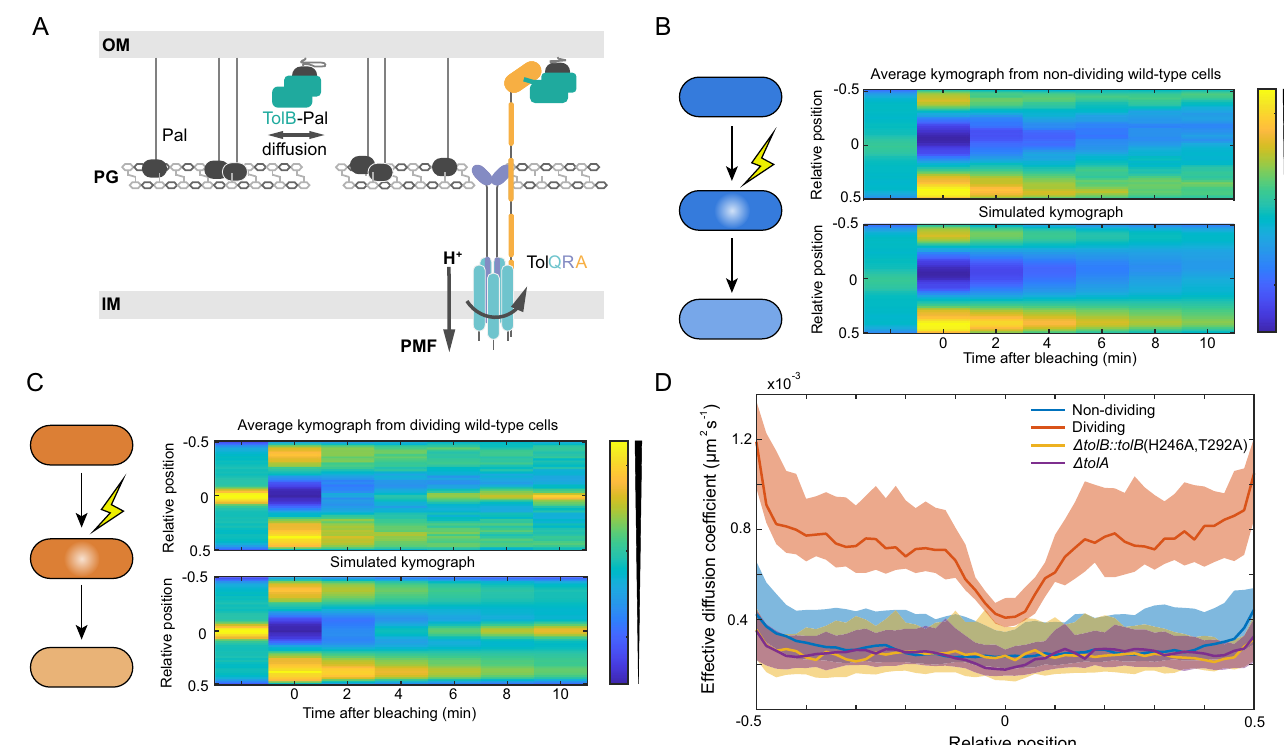
Fig 1. Pal in dividing cells is mobilised by TolQRA. (A) Major components of the Tol-Pal system. Pal is an outer membrane (OM) lipoprotein (black) that can bind meso -diaminopimelic acid within peptidoglycan (PG) or the periplasmic protein TolB (green) in a mutually exclusive manner. The inner membrane (IM) protein TolA spans the periplasm and is coupled to the PMF via its interaction with TolQ and TolR. TolA is also able to interact with TolB and can form a tripartite complex of TolA-TolB-Pal [4]. (B) Top, average kymograph of Fluorescence Recovery After Photobleaching (FRAP) of Pal-mCherry over 30 non- dividing wild-type cells where the colour scale indicates normalised fluorescence. Bottom, simulated kymograph obtained using the SpatialFRAP method by fitting to the data above. (C) Same as in (B) for 30 dividing wild-type cells. (D) The effective diffusion coefficient of Pal as a function of the relative cellular location in individual non-dividing, dividing, Δ tolA , and Δ tolB :: tolB (H246A,T292A) cells. TolB H246A T292A is a mutant that is unable to bind Pal. Shown is the median as a function of relative long axis position with 95% confidence intervals for approximately 30 cells. Data in (B)-(D) reproduced from reference [5].